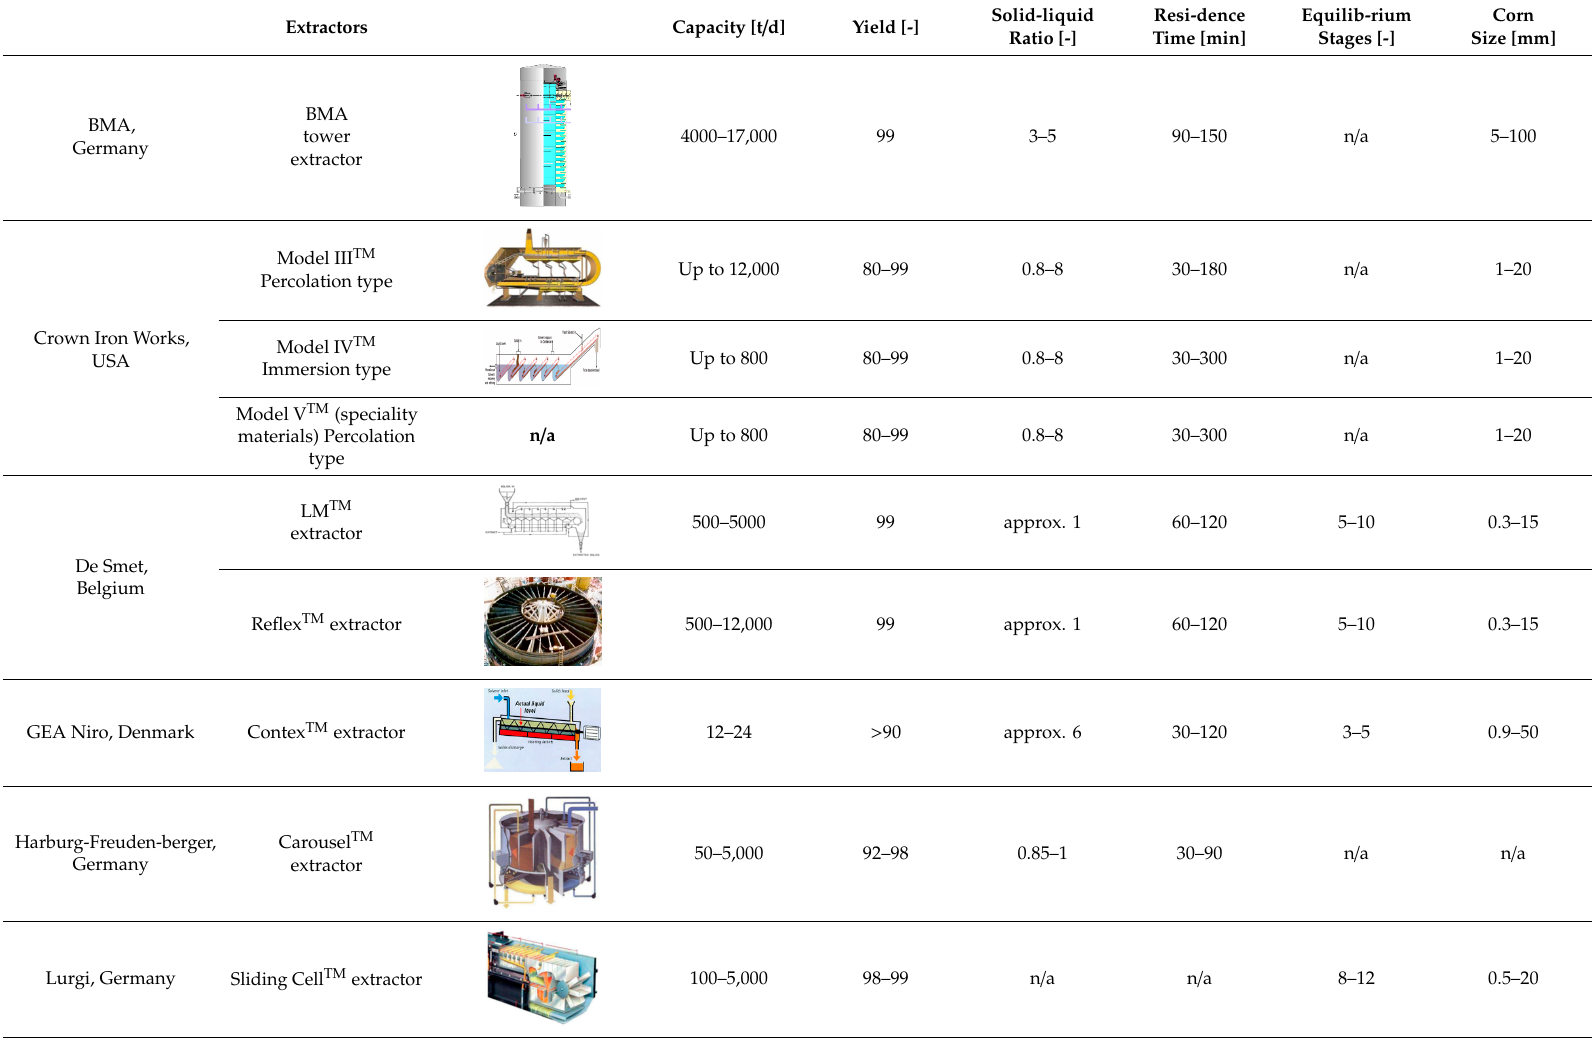
Table 5. Overview of di ff erent apparatuses for continuous processing of biomass [32].